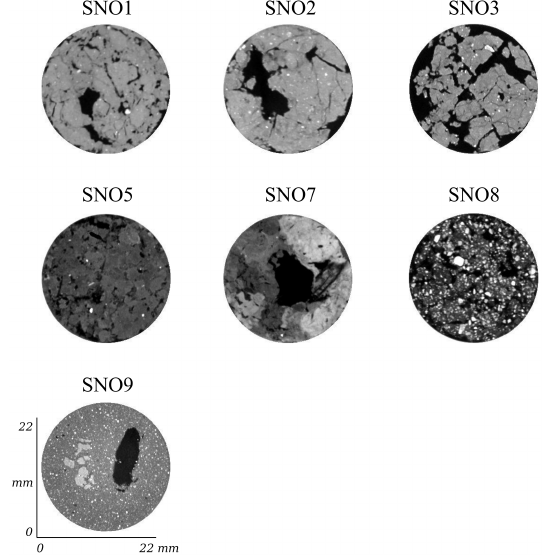
Figure 8. Cross sections of the reference images of the seven intact soil samples. Depth from the soil surface: SNO1, SNO2 and SNO3 at 8mm; SNO5 at 15mm; SNO7 and SNO8 at 9mm; and SNO9 at 5mm.